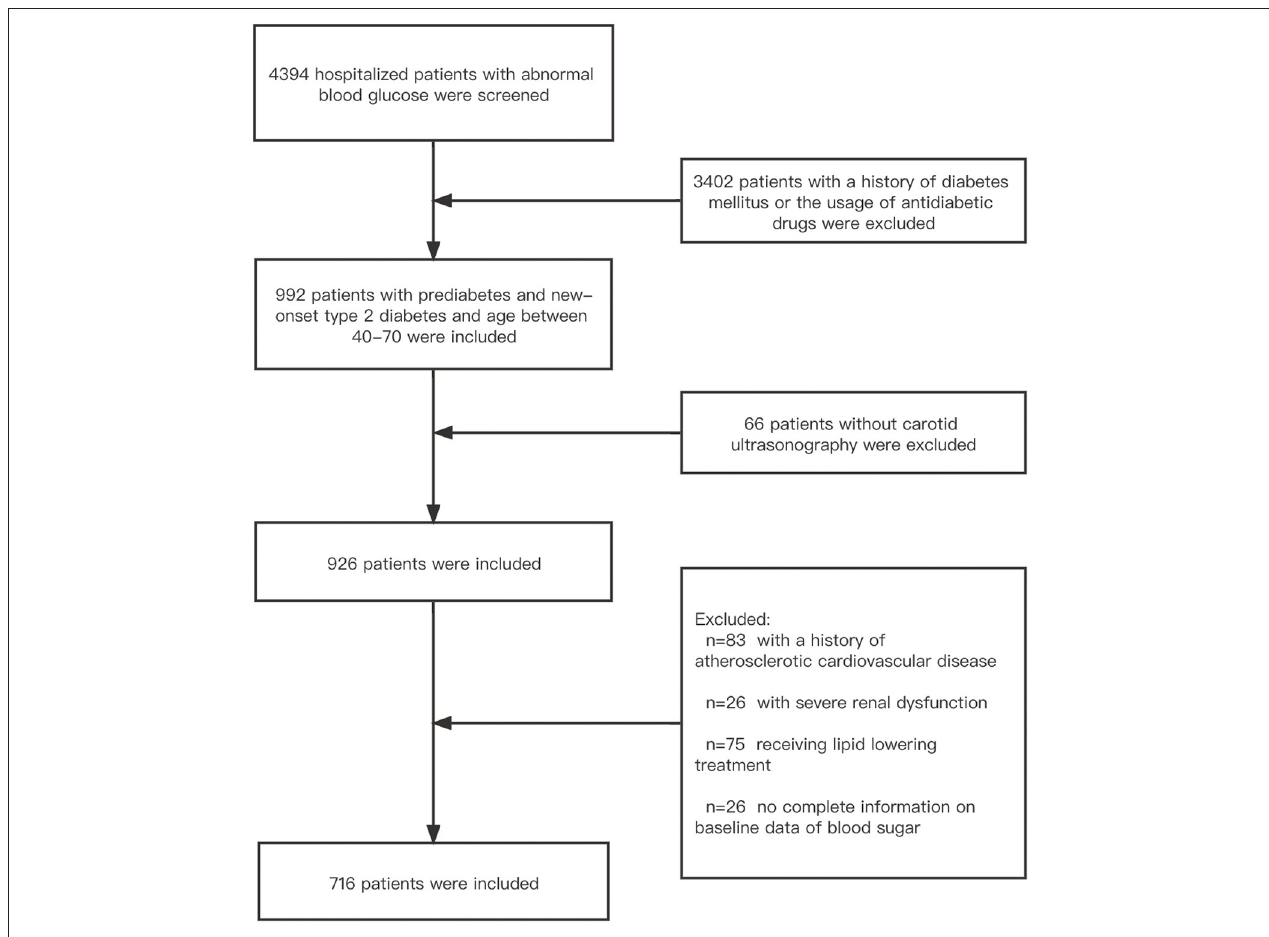
FIGURE 1 | Enrollment flowchart of the study